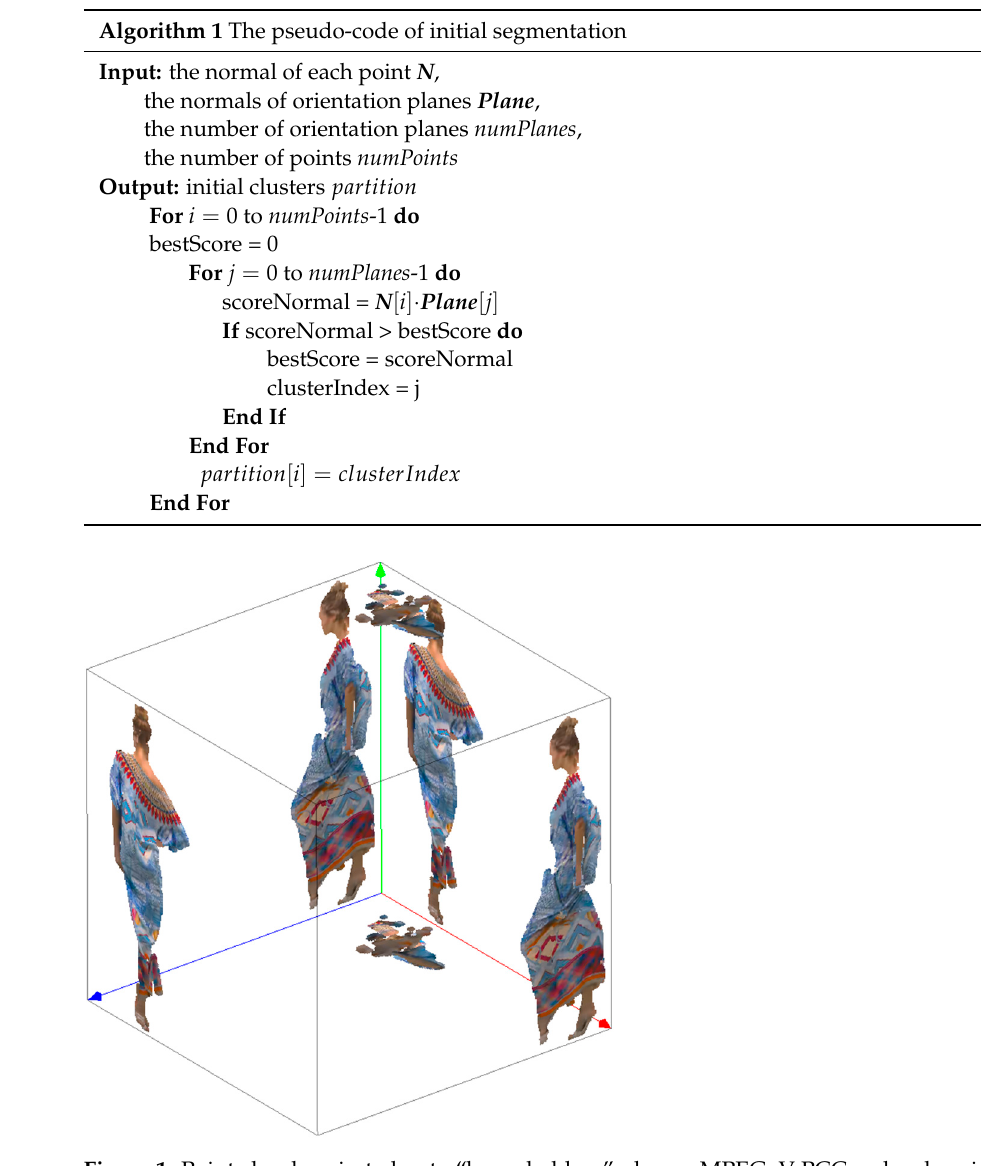
Algorithm 1 The pseudo-code of initial